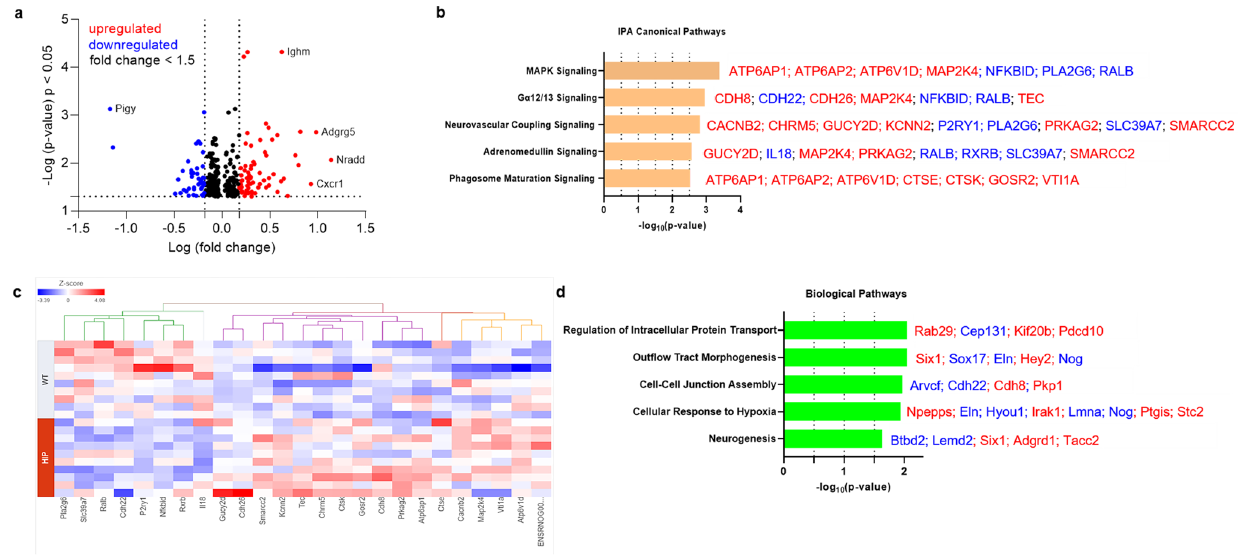
Fig. 7 The genes predicted to in fl uence the impact of cerebrovascular amylin deposition on the central nervous system. a The Log 10 ( p -value) versus Log 10 (fold change) of the DE genes in HIP vs. WT rat brains. Each dot represents one gene, with upregulated in red color (HIP vs. WT, ≥ 1.5-fold change), downregulated in blue color (HIP vs. WT, ≥ 1.5-fold change), and < 1.5-fold change in black color. b Top 5 canonical pathways identi fi ed by Ingenuity Pathways Analysis of differentially expressed (DE) genes detected by RNA-seq analysis of hippocampal tissue from the HIP vs. WT rat groups ( P < 0.05) ( n = 10 males/group). c Hierarchical clustering of 25 DE genes identi fi ed the enrichment of top 5 canonical pathways in ( b ). d Top 5 Gene Ontology (GO) biological processes enriched in HIP rat group compared to WT rat